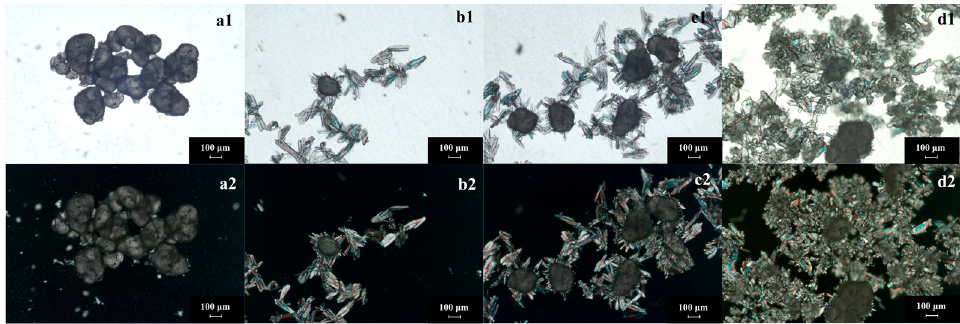
Figure 7. Image of the process of seed method to produce crystalline products.